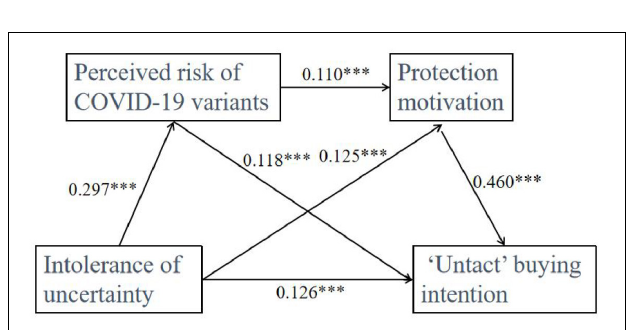
FIGURE 2 | The serial mediation model. *** p <